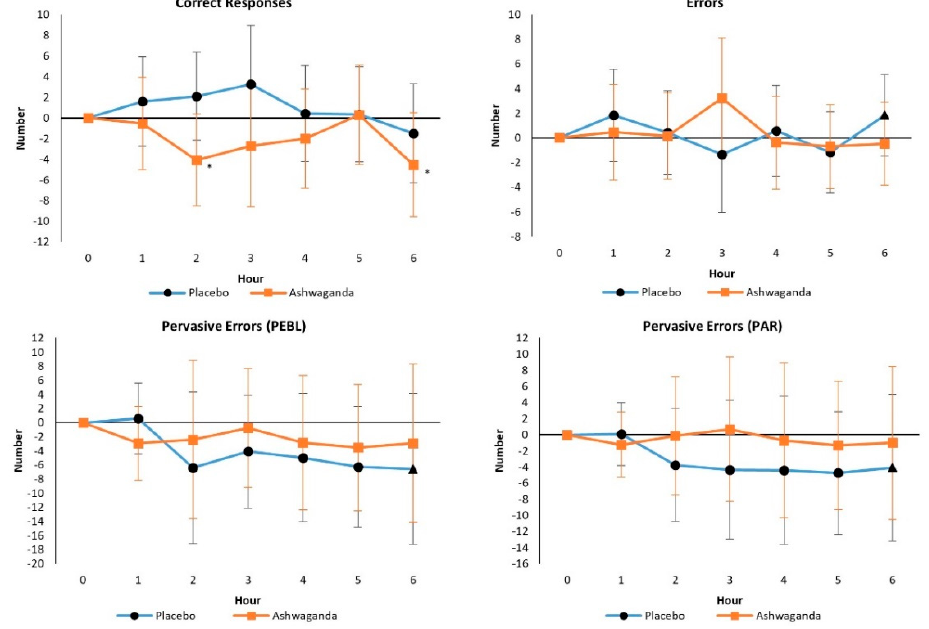
Figure 3. Berg Card Sorting Test responses. Data are mean differences from baseline with 95% confidence intervals. * indicates p > 0.05 to p < 0.10 difference between treatments.